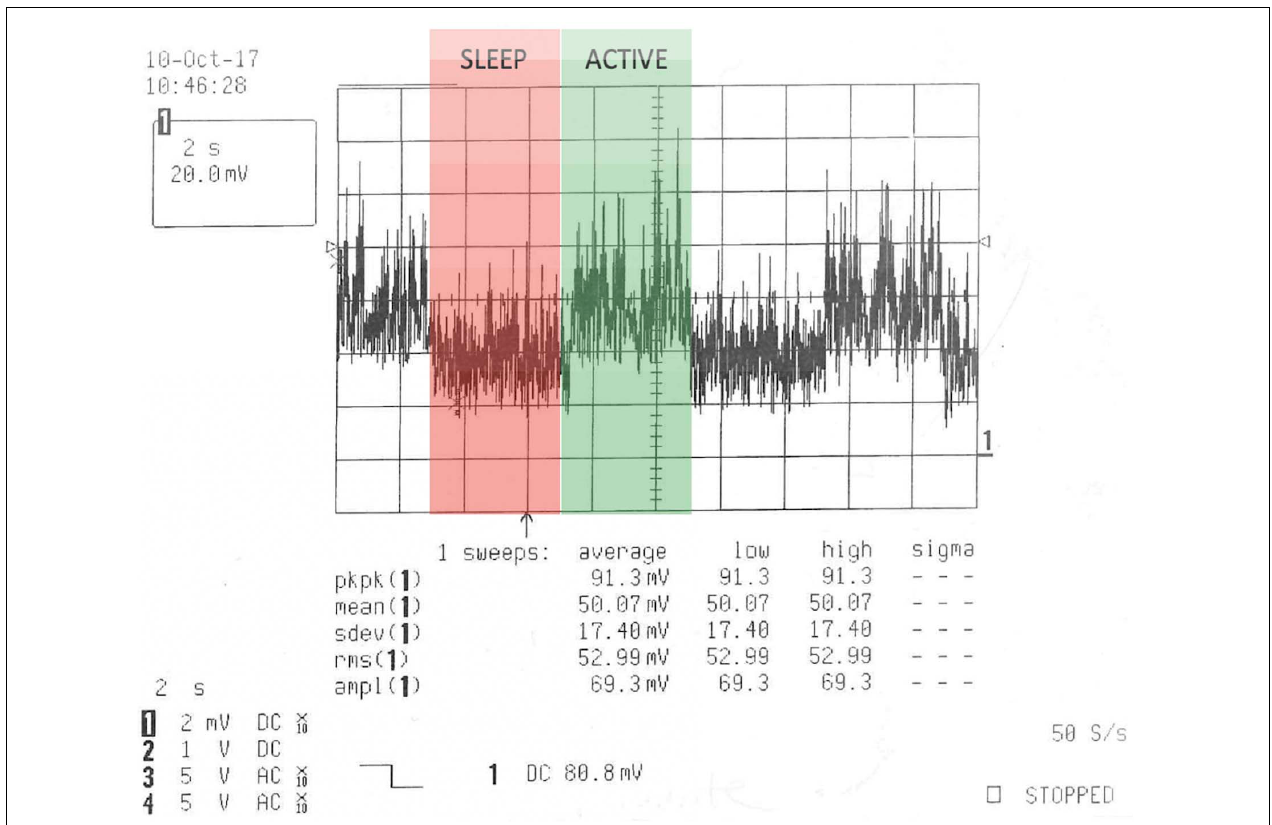
FIGURE 6 | Power consumption of the MaDCrow acquisition and transmission system in sleep and active mode.